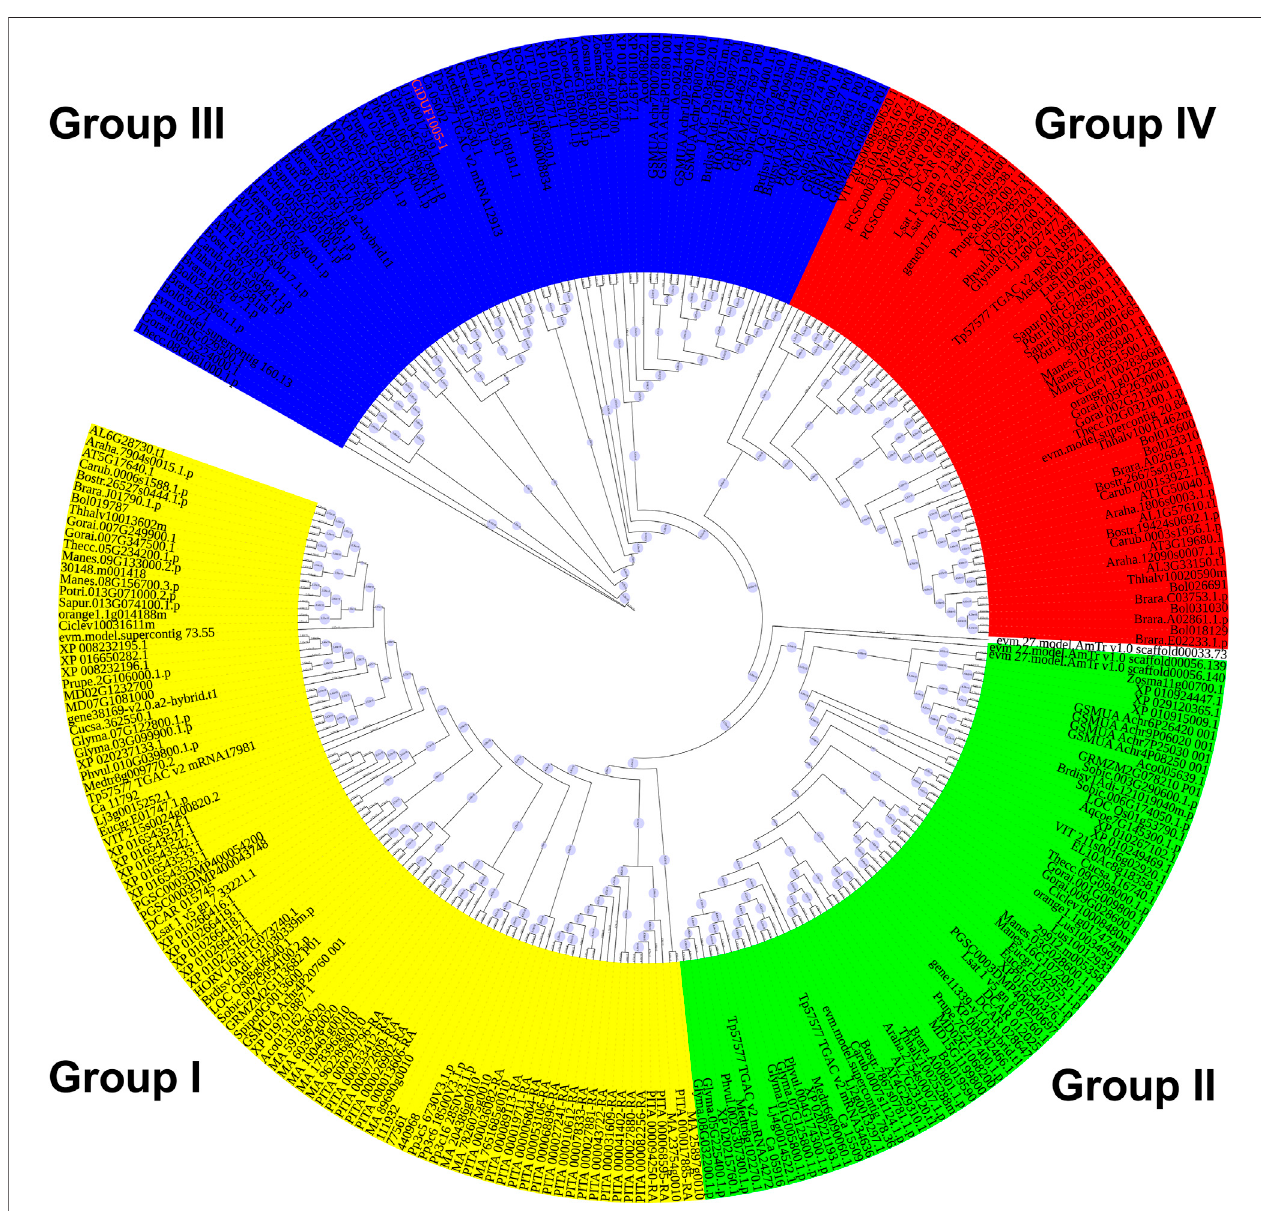
FIGURE 2 | Phylogenetic classi fi cation of DUF1005 genes in plants. A phylogenetic tree was constructed using the maximum likelihood (ML) method with IQ-tree. The yellow color represents Group I, the green color represents Group II, the blue color represents Group III, and the red color represents Group IV.